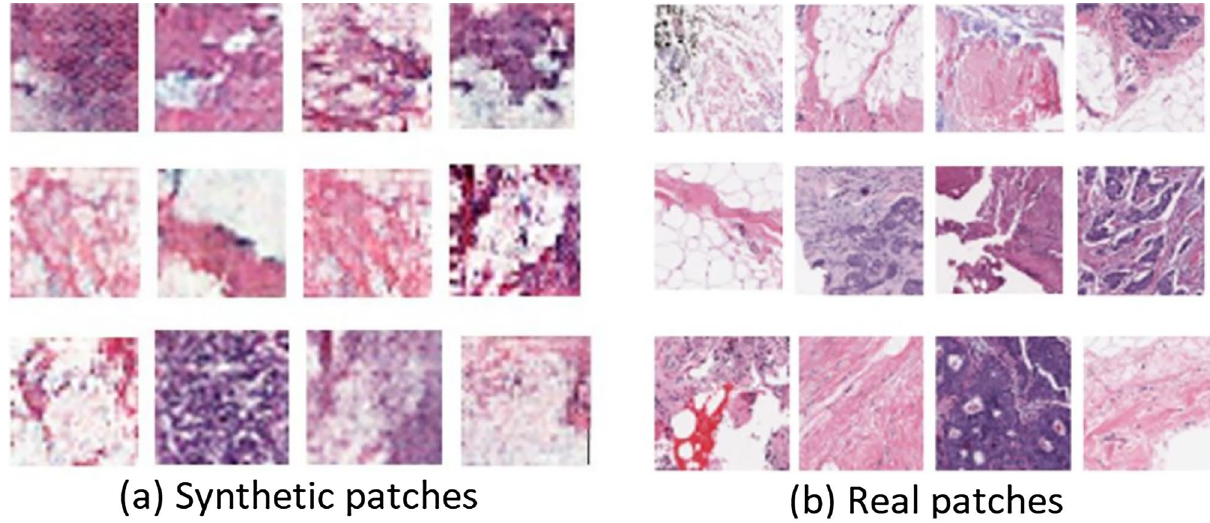
Figure 3. Examples of real and GAN generated synthetic patches.